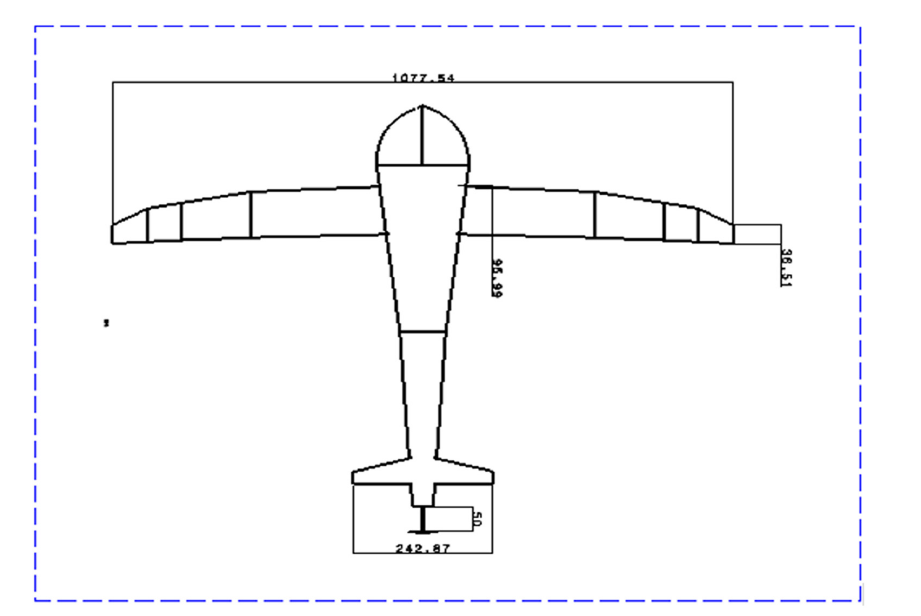
Figure 6. Design draft of the complete nature-based UAV—A typical view—1.